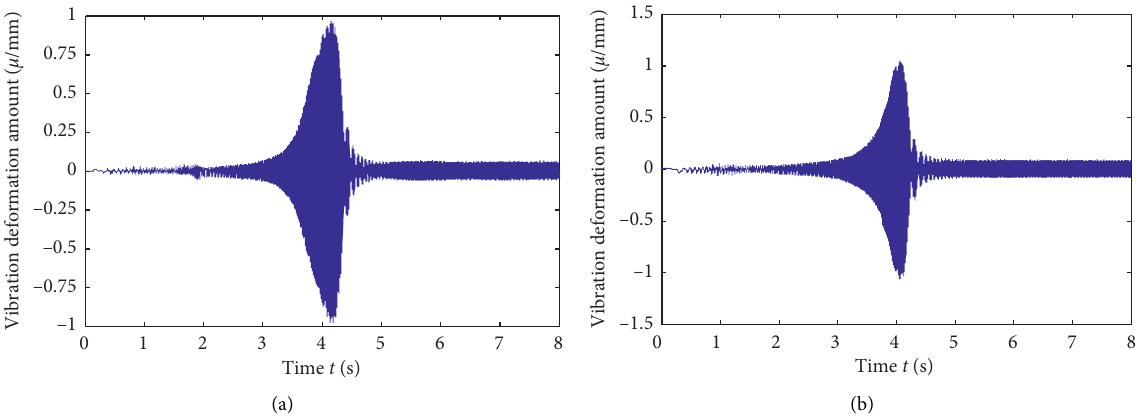
Figure 13: Effect of the position of support III on the vibration deformation of the shafting across the first-order critical speed. (a) Supports’ positions 0 mm, 0 mm, − 60mm. (b) Supports’ positions 0mm, 0mm, − 30mm.